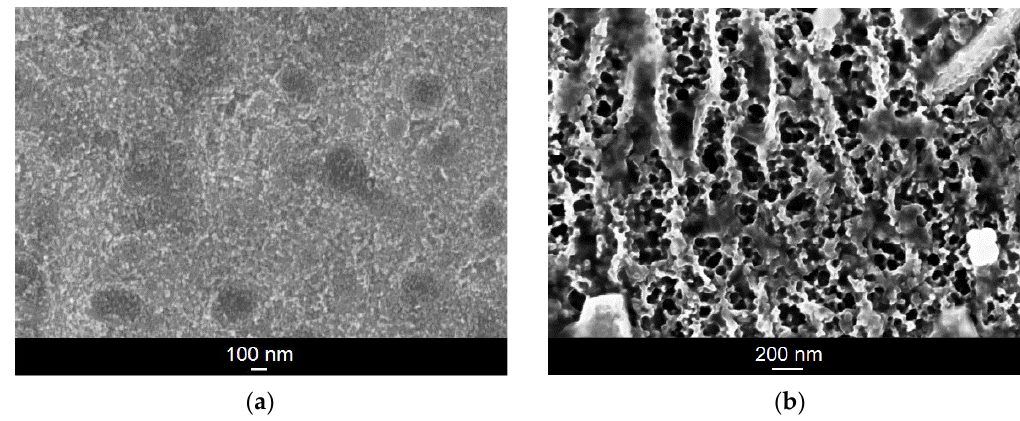
Figure 1. SEM image of the microstructure of the oxide layer formed on the Ti – 6Al – 7Nb alloy in 1 M EG + 0.2 M NH 4 F electrolyte under anodizing conditions: ( a ) 5 V for 120 min; ( b ) 100 V for 15 min.